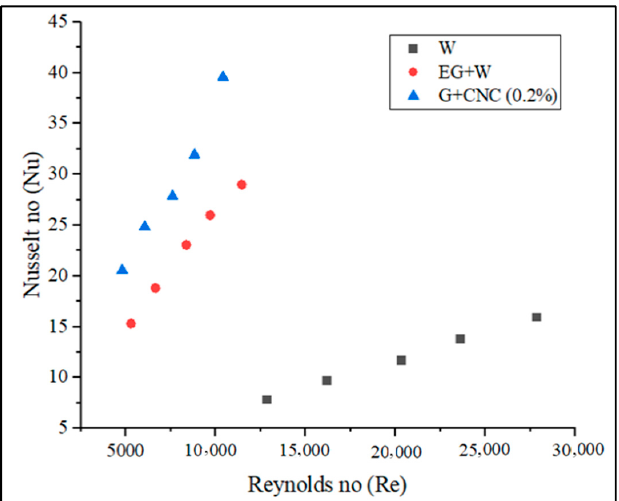
Figure 17. Nusselt number (Nu) vs. Reynolds number (Re).